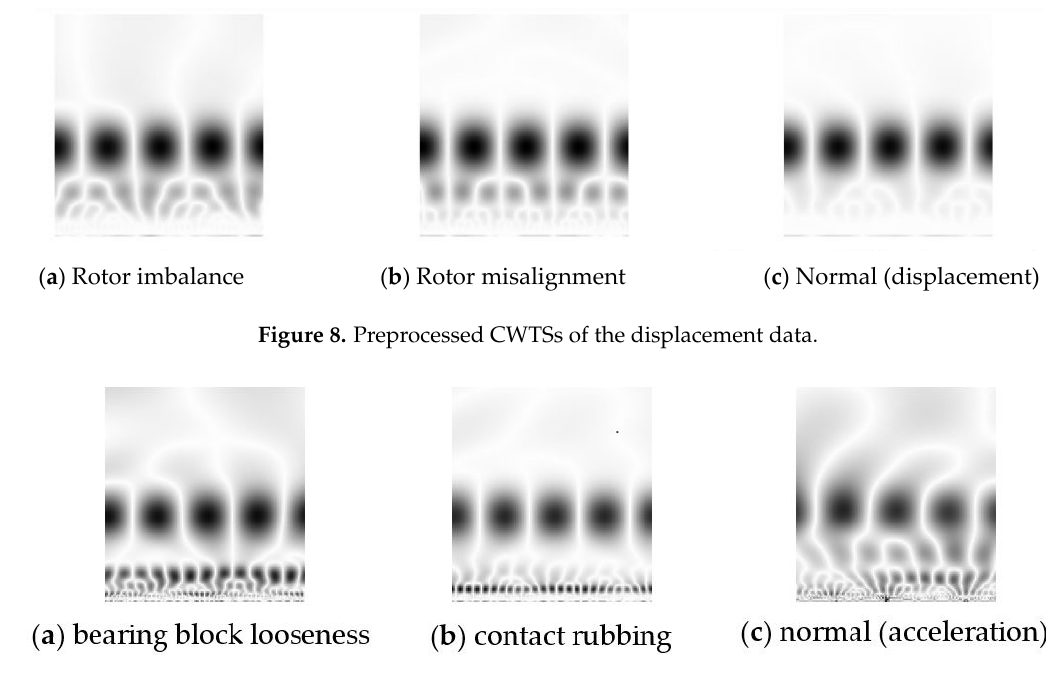
Figure 9. Preprocessed CWTSs of the acceleration data.